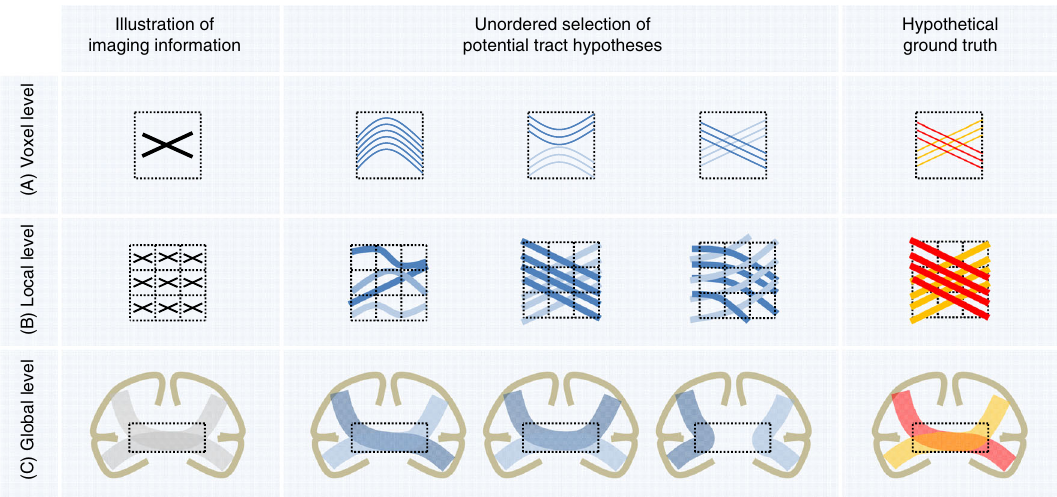
Fig. 7 Ambiguous correspondences between diffusion directions and fi ber geometry. The three illustrations at voxel, local, and global level are used as an example to illustrate the possible ambiguities contained in the diffusion imaging information that may lead to alternative tract reconstructions. (A) The intra-voxel crossing of fi bers in the hypothetical ground truth leads to ambiguous imaging information at voxel level 7 . (B) Similarly, the imaging representation of local fi ber crossings can be explained by several other con fi gurations 7 . (C) At a global level, white matter regions that are shared by multiple bundles (so-called “ bottlenecks ” , dotted rectangles) 35 can lead to many spurious tractographic reconstructions 36 . With only two bundles in the hypothetical ground truth (red and yellow bundle), four potential false-positive bundles emerge. Please note that the hypothetical ground truth used in the global-level example is anatomically incorrect as most of the callosal fi bers are homotopically distributed (i.e., connect similar regions on both